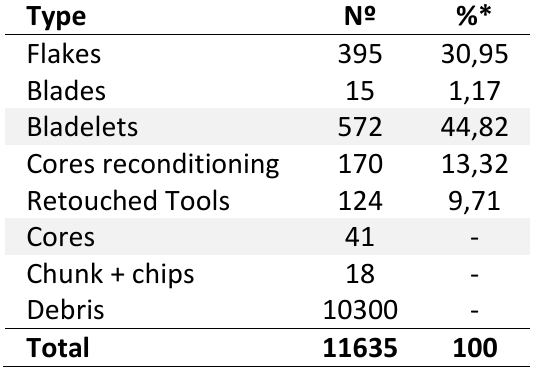
Table 2. Analysed lithic assemblage. Level P/5 of El